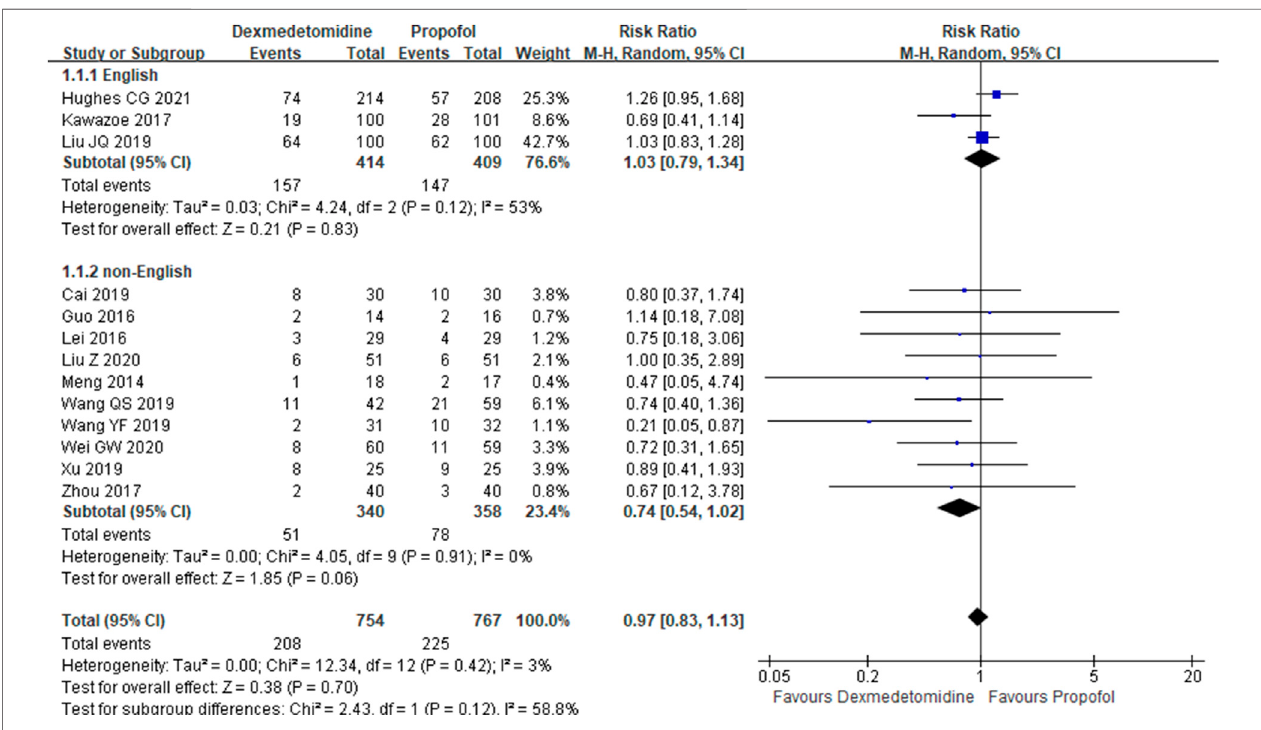
FIGURE 2 | Forest plot of 28-day mortality.